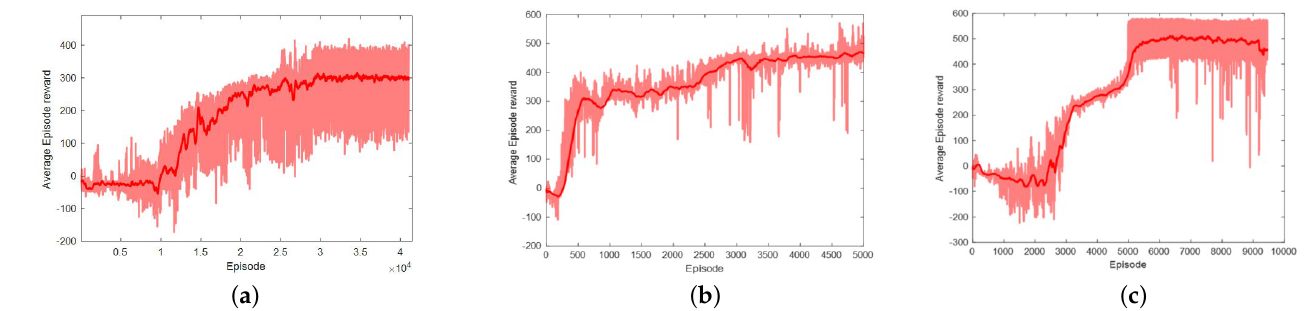
Figure 5. The curves of accumulative reward for each training episode. ( a ) DDPG. ( b ) TD3. ( c )